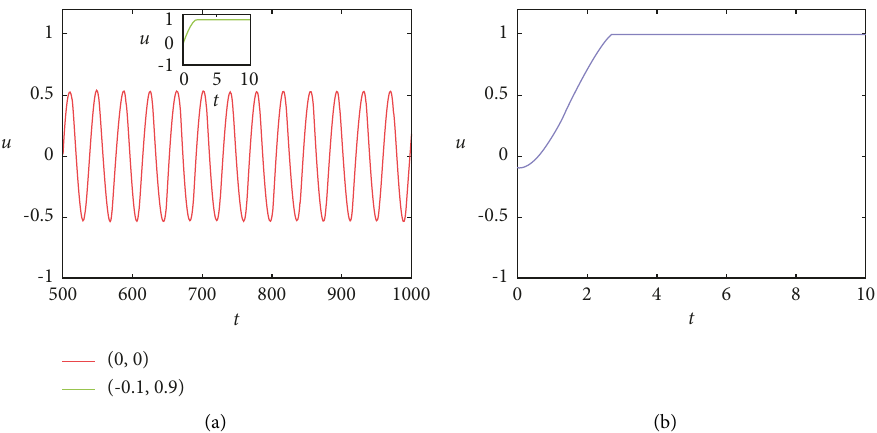
Figure 4: Time histories of system (2) under different values of f